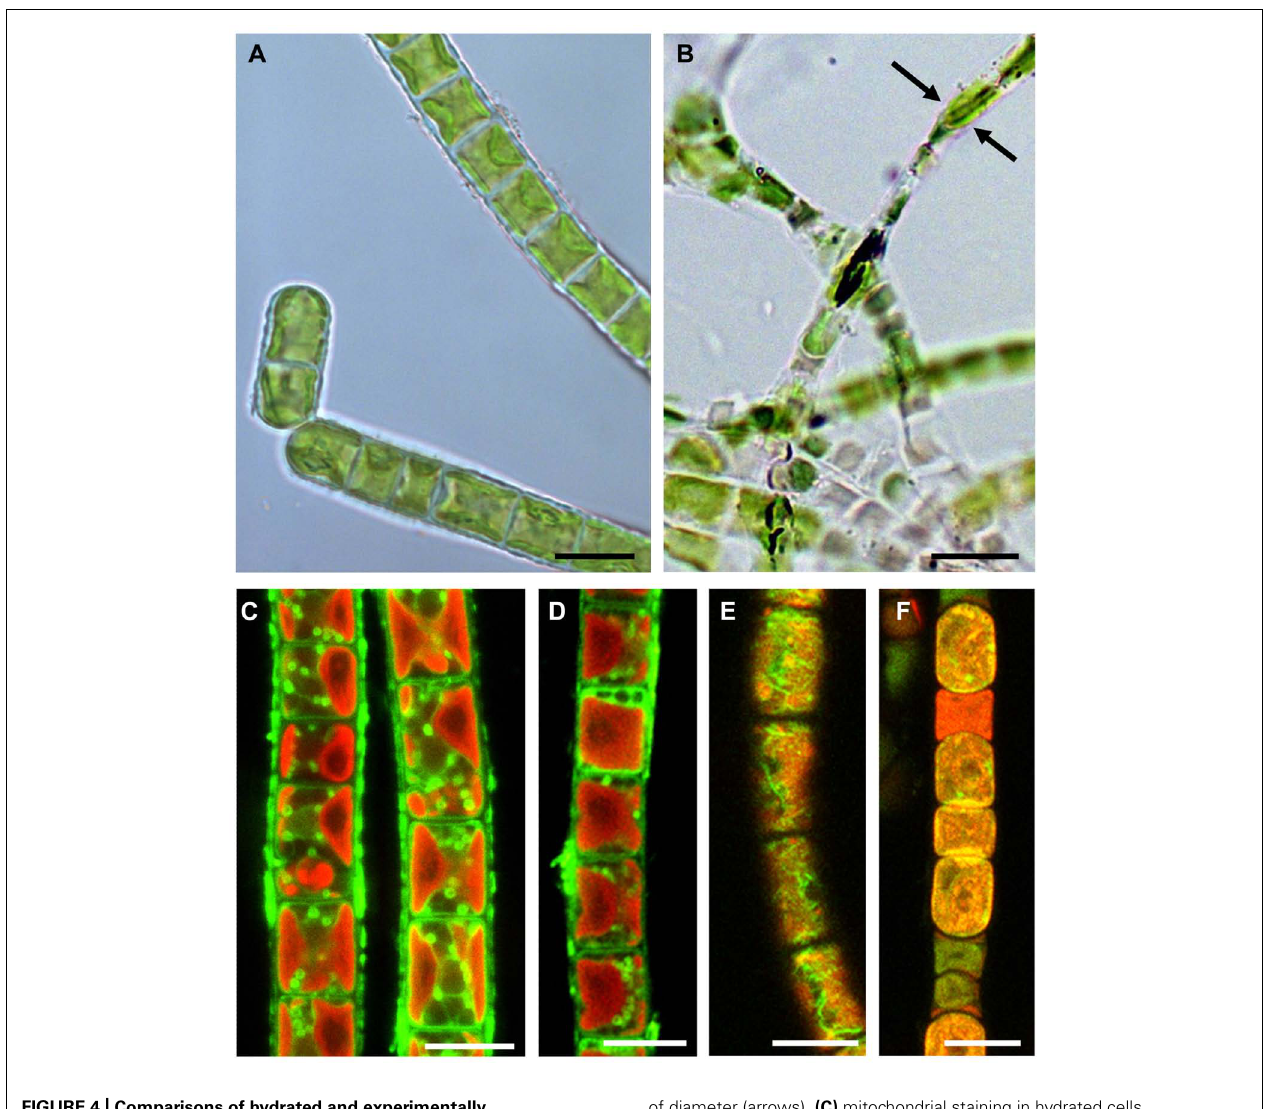
FIGURE 4 | Comparisons of hydrated and experimentally desiccated cells of the streptophytic green alga Klebsormidium crenulatum observed by light- (A,B) and confocal laser scanning microscopy (C–F). (A) cells form liquid culture, (B) cells desiccated for 1 day at ∼ 5% RH and observed in immersion oil, note the loss